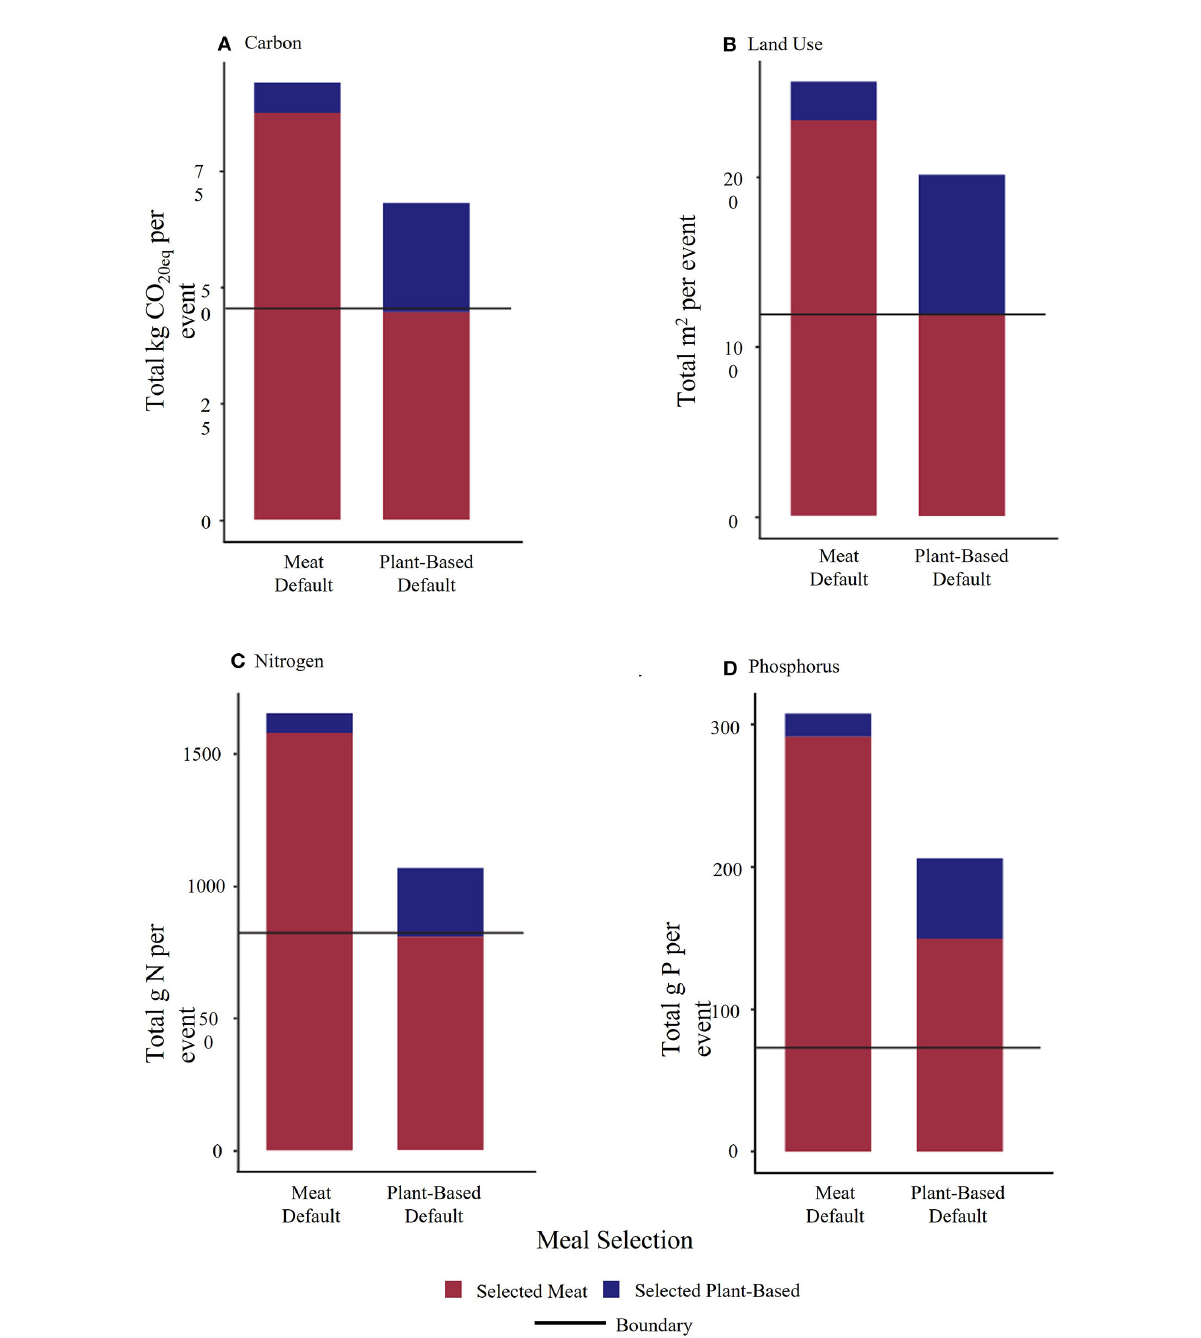
FIGURE2 (A–D) Plant-based and chicken projected event calculations using the pooled RCTs. Colors represent breakdown of impacts from meat and veg meals. Black line represents EAT Lancet’s planetary boundary for the measure (Willett et al., 2019).